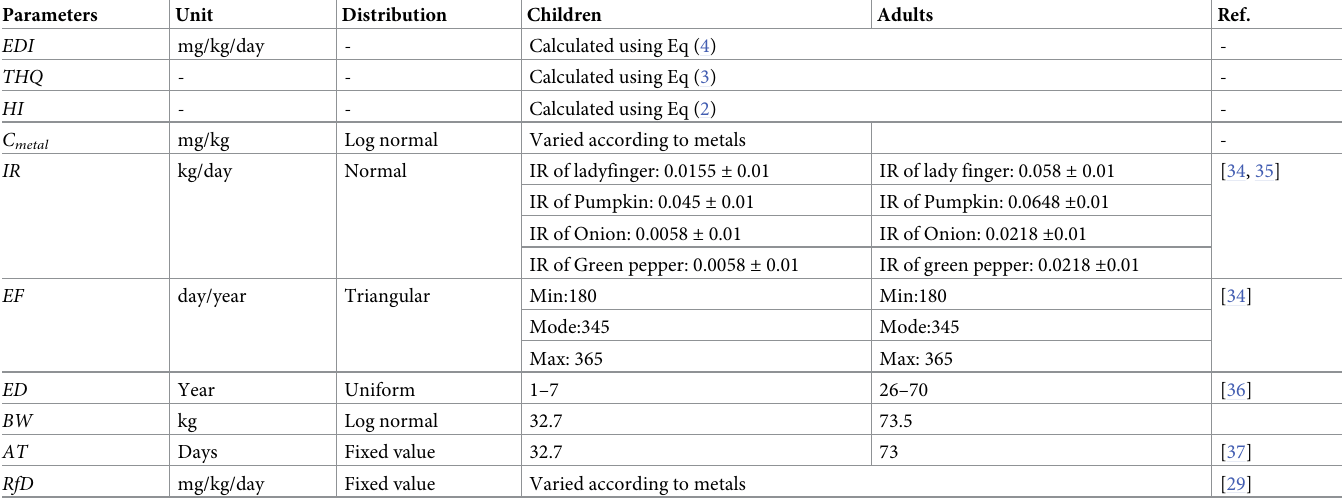
Table 1. Distributions of parameters for different population groups used in risk assessment model with Monte Carlo simulation.